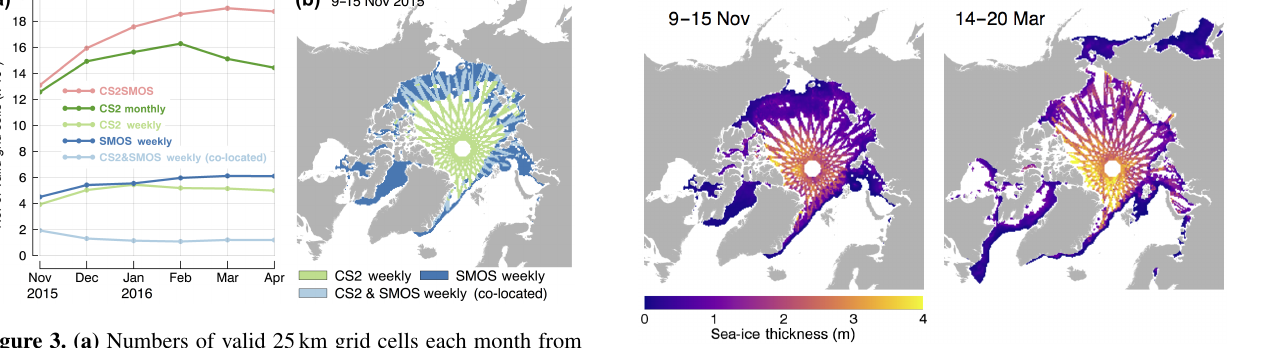
Figure 4. Weighted means of CryoSat-2 and SMOS weekly means during the target week, produced from fields shown in Fig.